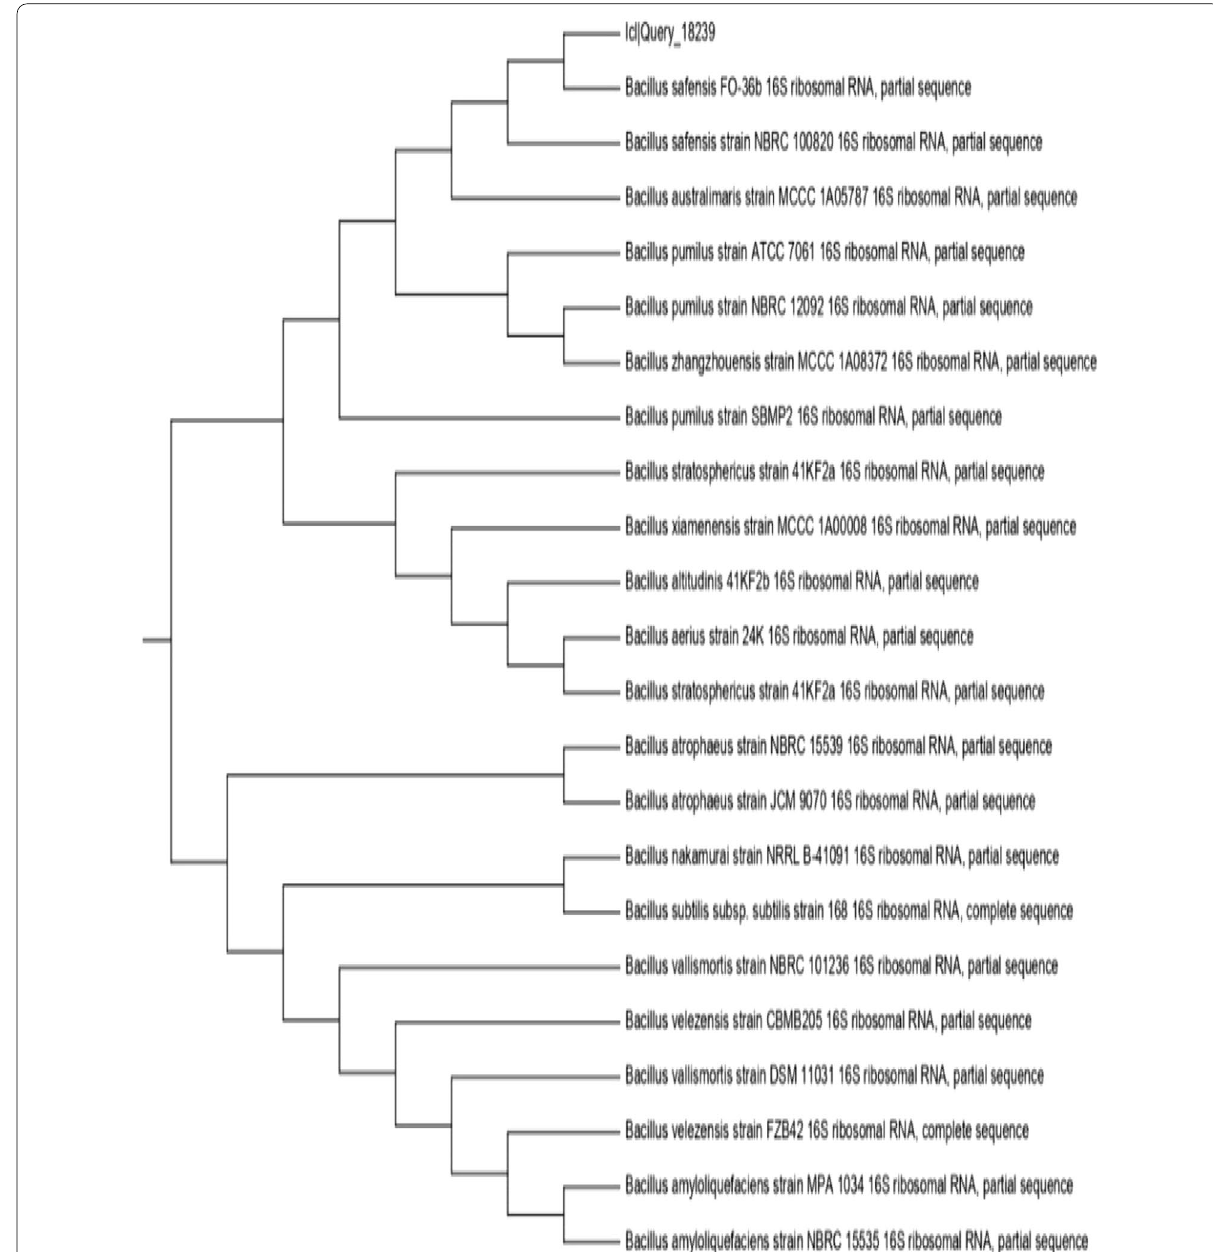
Fig. 4 Phylogenetic tree of Bacillus safensis compared to closely related organisms in